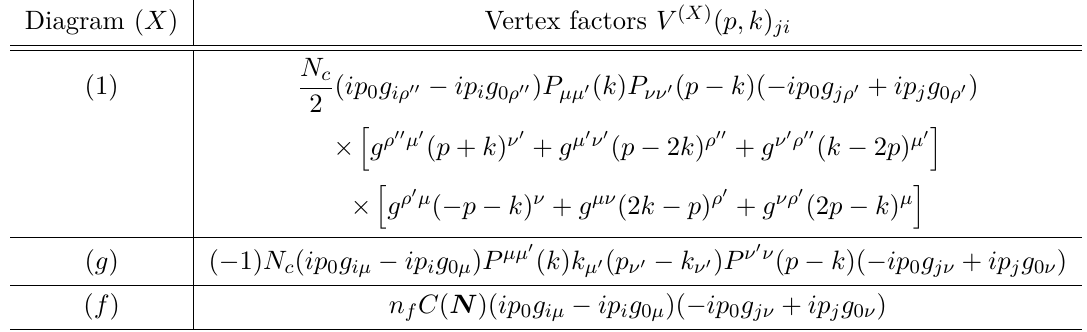
(cid:2) (cid:3) da g ++ . E ji,JI